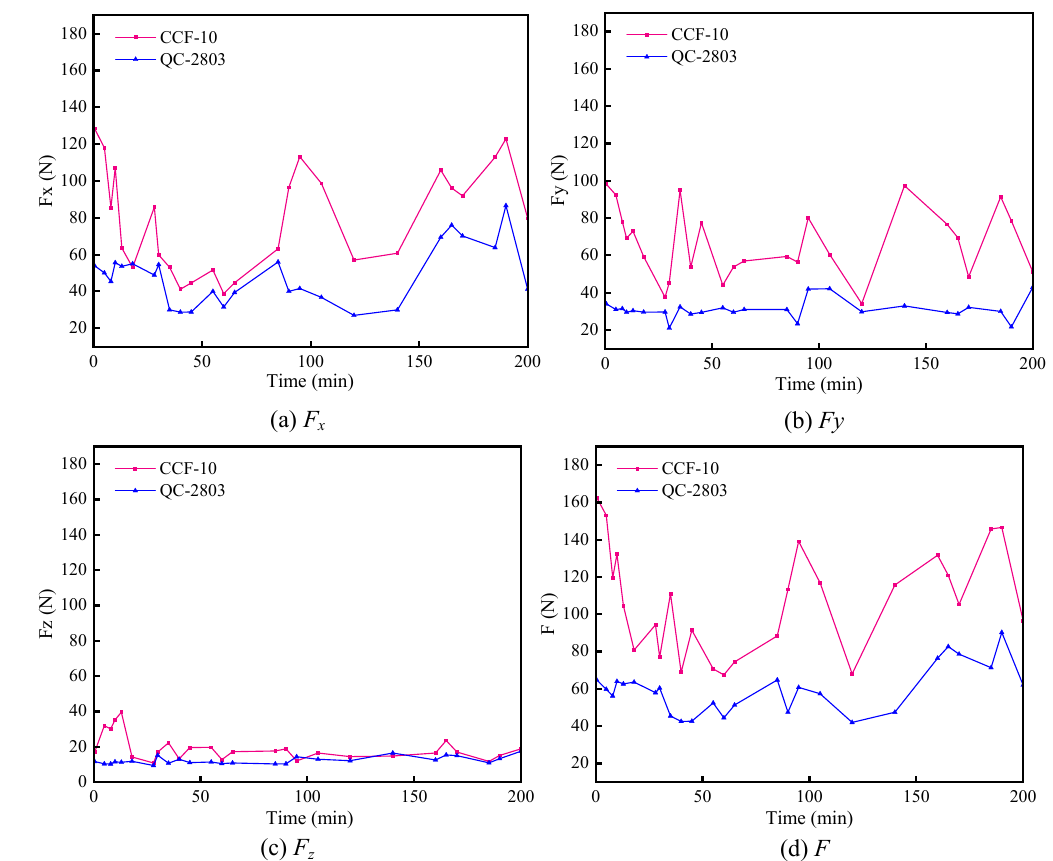
Figure 10. Cutting forces and its direction under two cutting fluid conditions.